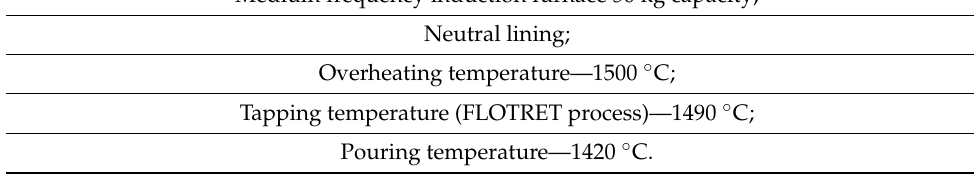
Table 2. Melting.